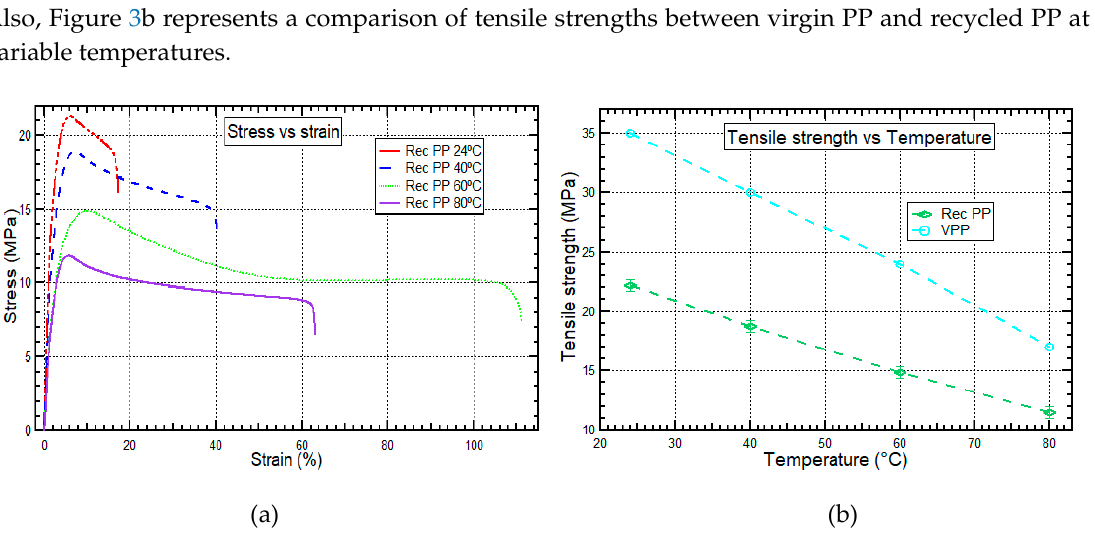
Figure 3. ( a ) Stress vs. strain behavior for recycled PP and ( b ) Tensile strength for recycled PP and virgin PP at 24 °C, 40 °C, 60 °C, and 80 °C. Data for virgin PP was obtained from Mallick [46].